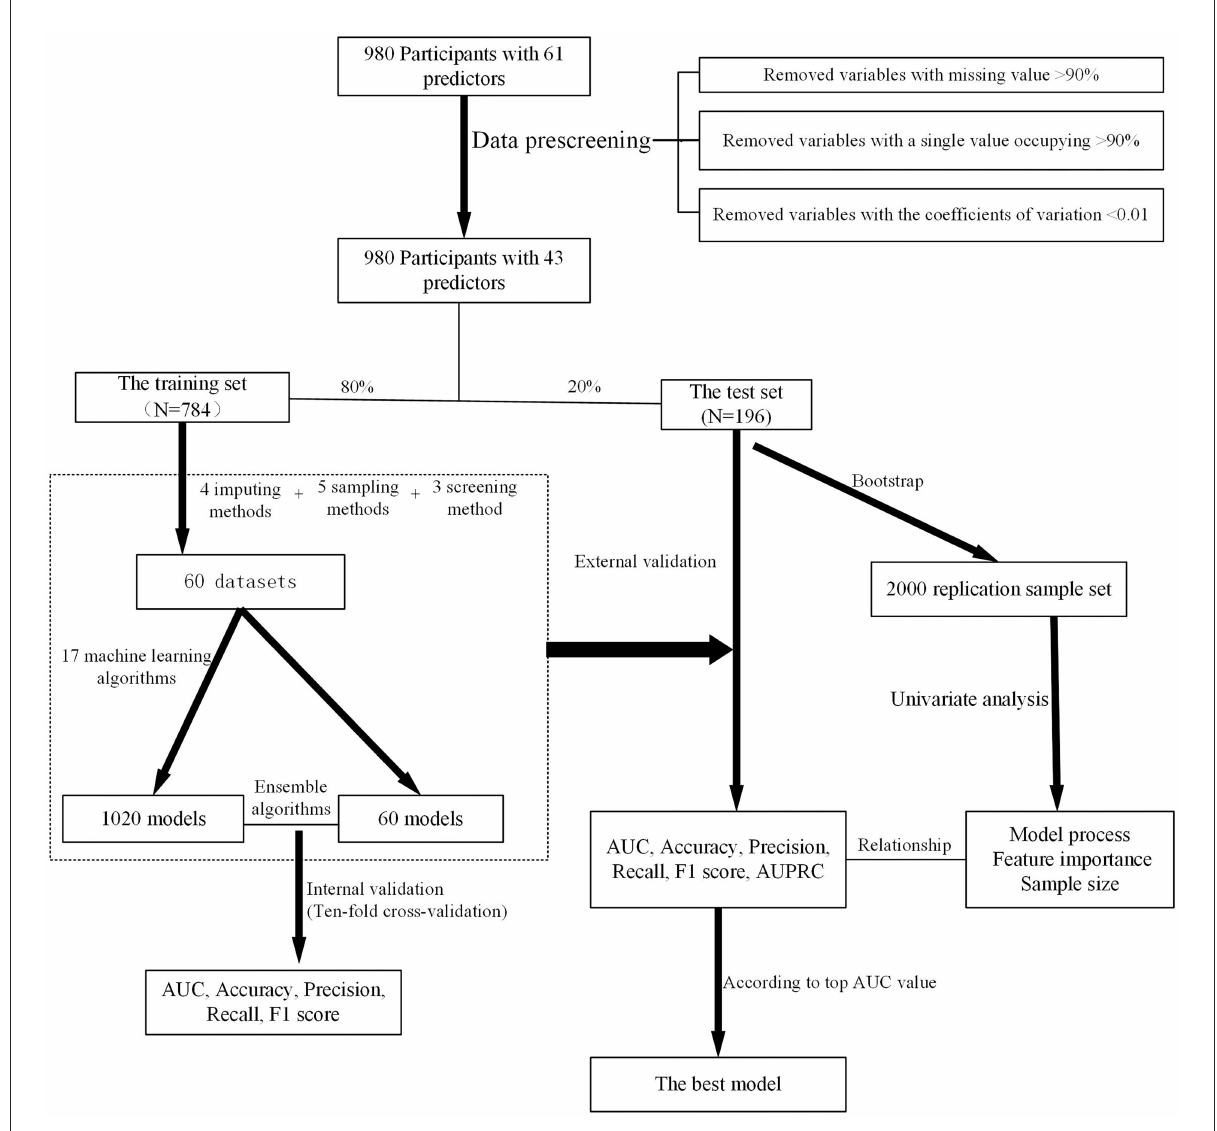
FIGURE1 The schematic flow of the main steps in this